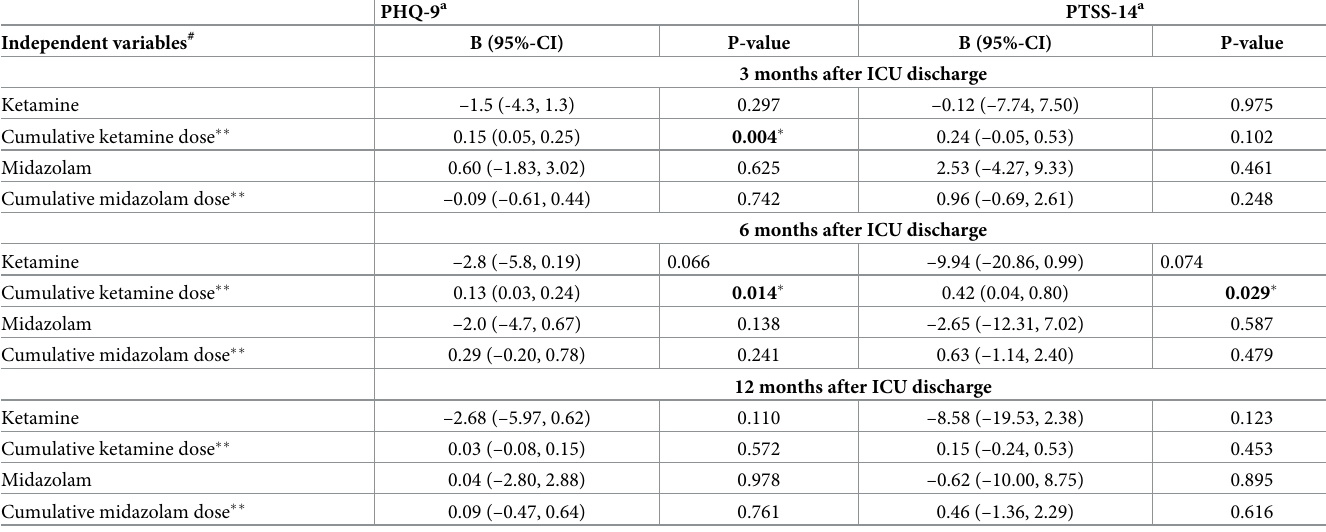
Table 4. Multiple linear regression models of the influence of cumulative ketamine doses on psychiatric symptoms in ARDS survivors 3, 6 and 12 months after ICU